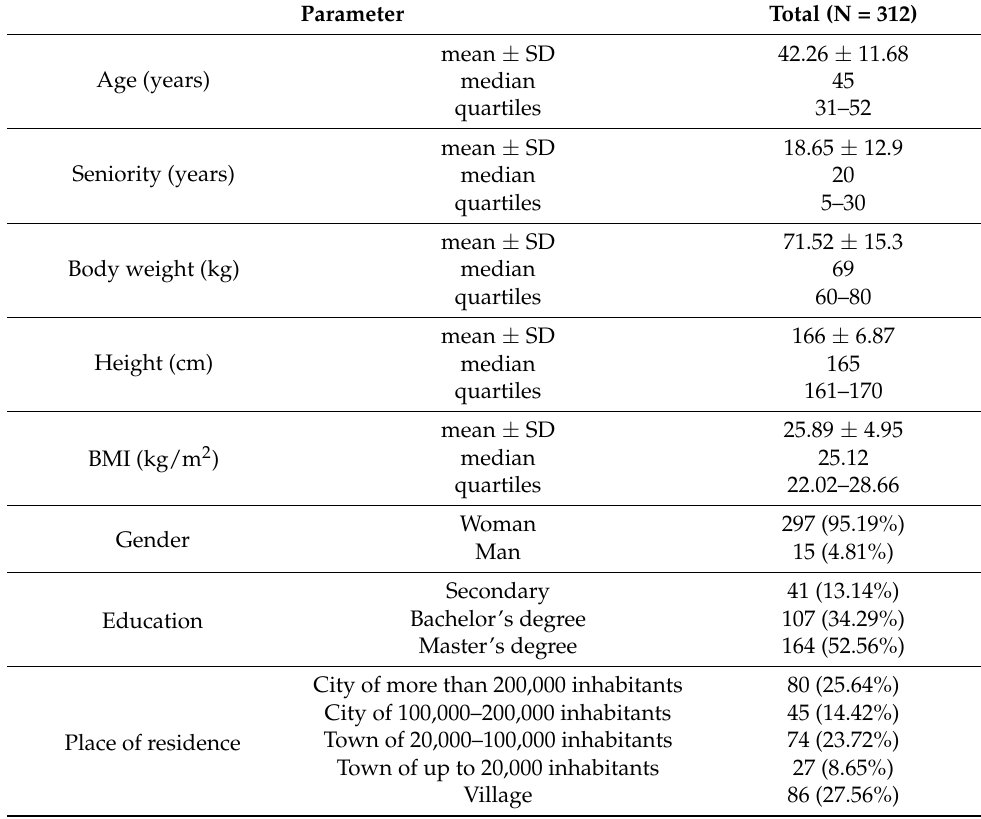
Table 1. Characteristics of the study